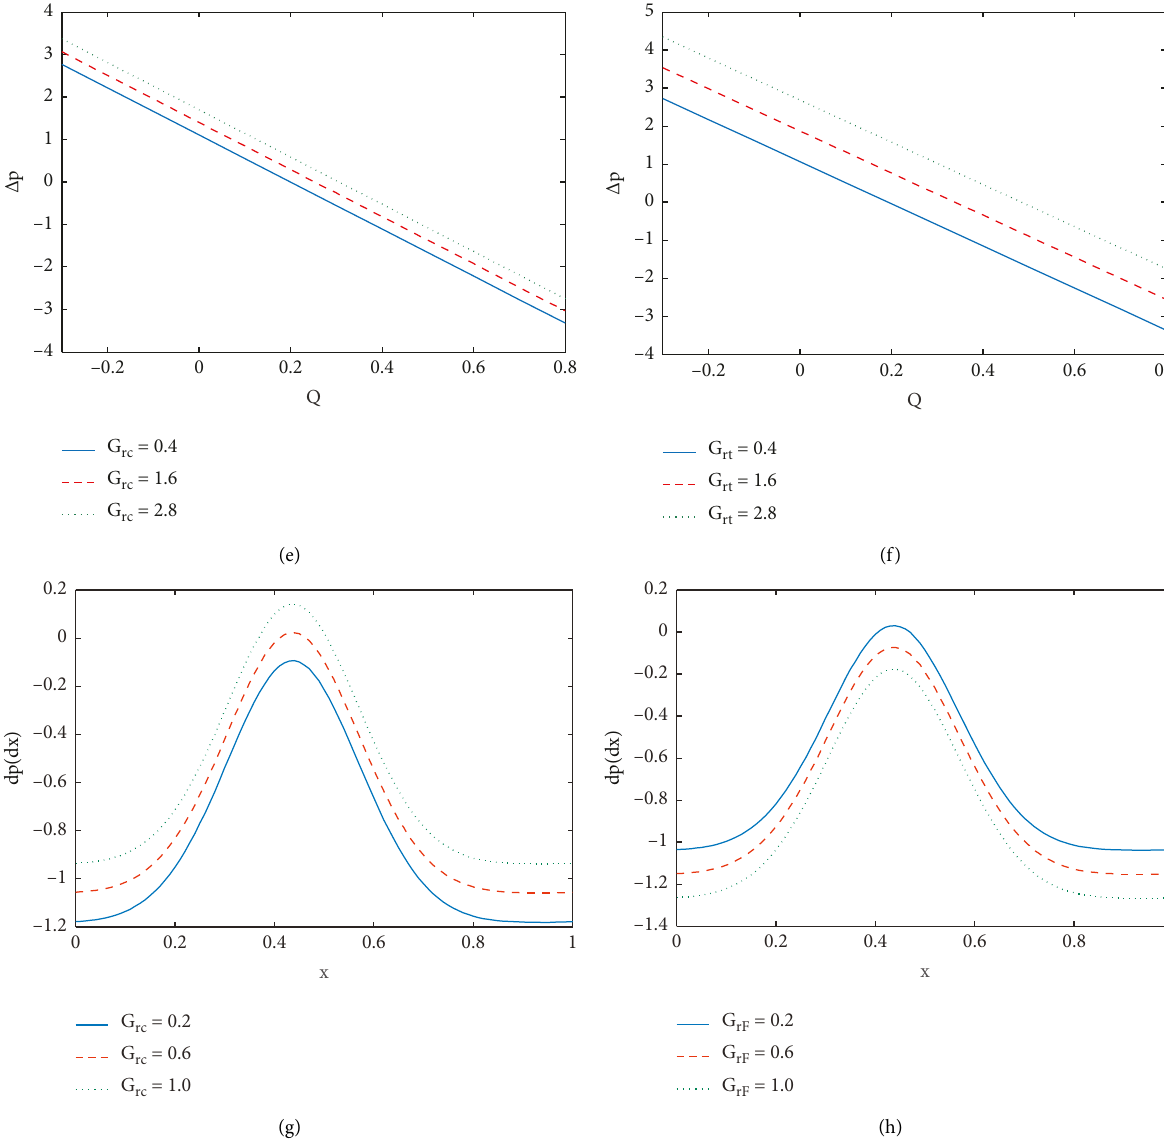
) , solutal ( G ) , and thermal ( G rF rc